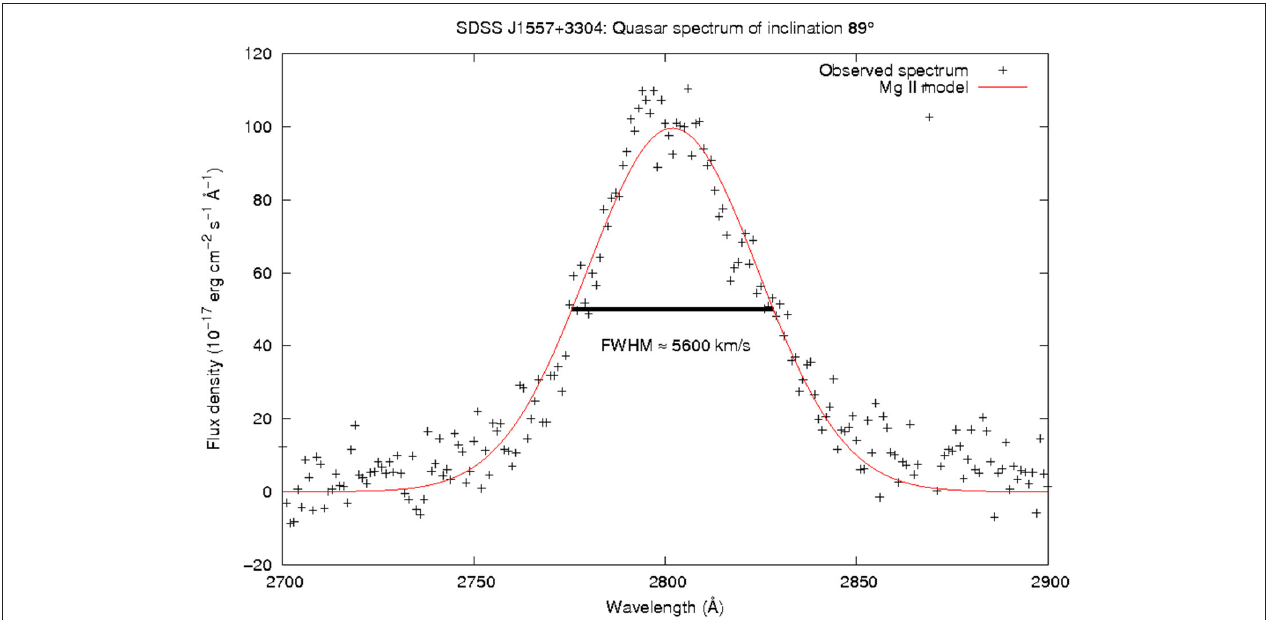
FIGURE 4 | Mg II broad line emission as it appears in the quasar SDSS J155729.93 + 330446.9. The black crosses indicate the quasar flux after the disk power-law and the SBB emission were subtracted. The red line indicates the model Mg II emission which, at 5,600 km s − 1 , easily meets the definition of a broad